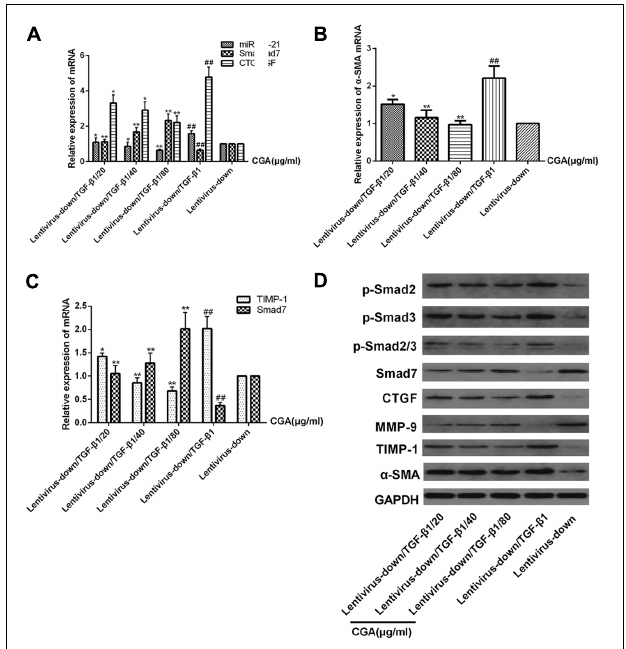
FIGURE 7 | Effects of CGA on the TGF- β 1/miR-21/Smad7 signaling pathway in LX2 cells after TGF- β 1 knockdown. (A–C) The mRNA levels were detected by real-time quantitative PCR. (D) The protein levels were assayed by western blotting. The data from three independent experiments are expressed as the means ± SD. ∗ P < 0.05 for lentivirus-down/TGF- β 1/CGA vs. lentivirus-down/TGF- β 1; ∗∗ P < 0.01 for lentivirus-down/TGF- β 1/CGA vs. lentivirus-down/TGF- β 1; ## P < 0.01 lentivirus-down/TGF- β 1 vs. lentivirus-down.